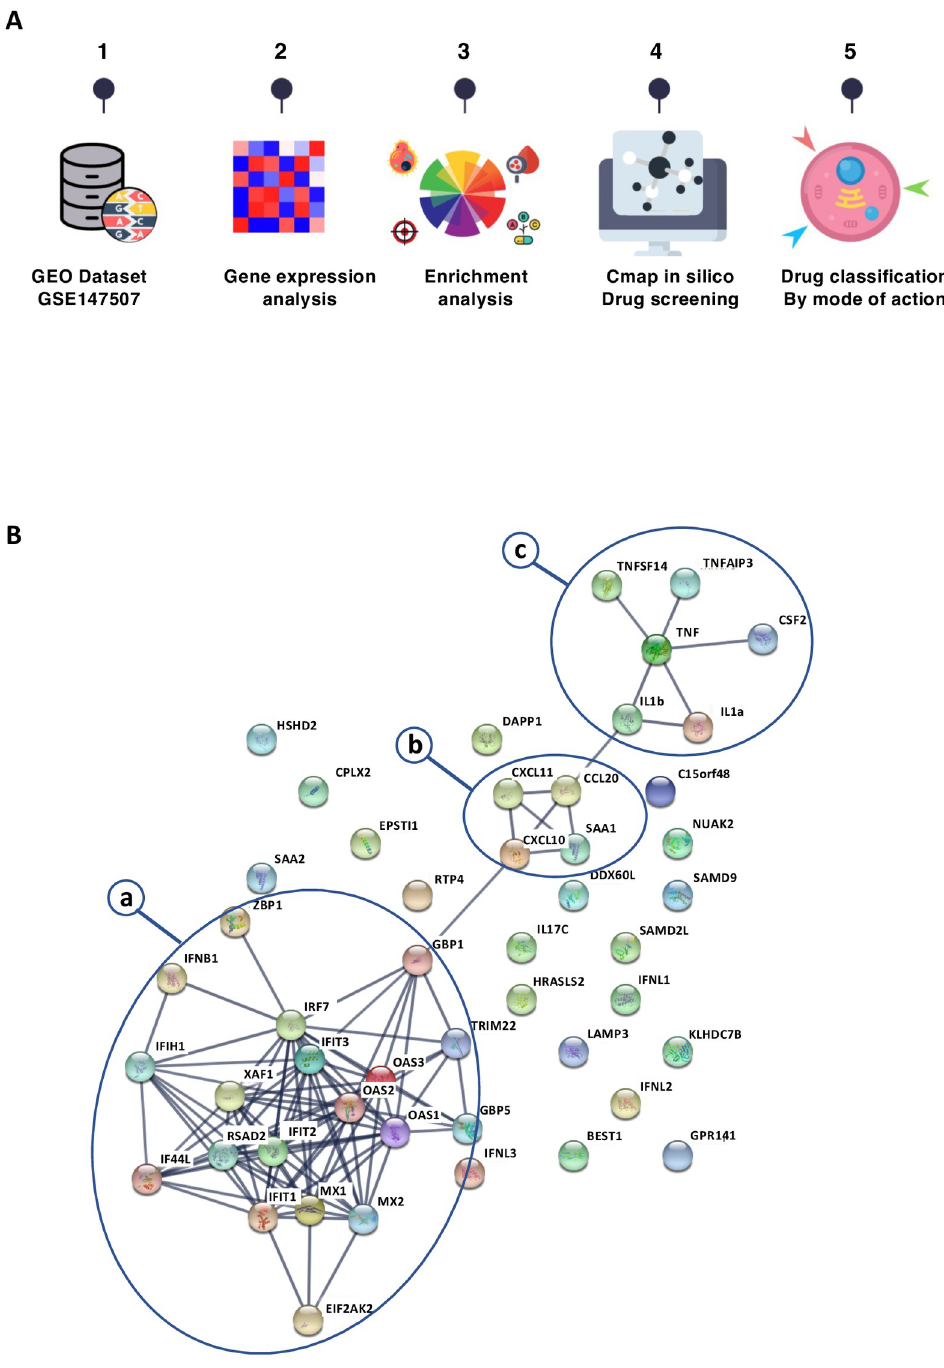
Fig 1. A: Workflow of the bioinformatic analysis. B: Using the protein-protein interaction STRING database, we queried our top 50 upregulated genes (sorted by LogFC). The network edges indicate both functional and physical protein associations, the line thickness represents the confidence, it indicates the strength of data support with a minimum required interaction score of 0.9 (most strict confidence filter). Three modules (a: interferon anti-viral proteins, b: interferon-induced chemokines, c: TNF and inflammatory cytokines) are encircled.